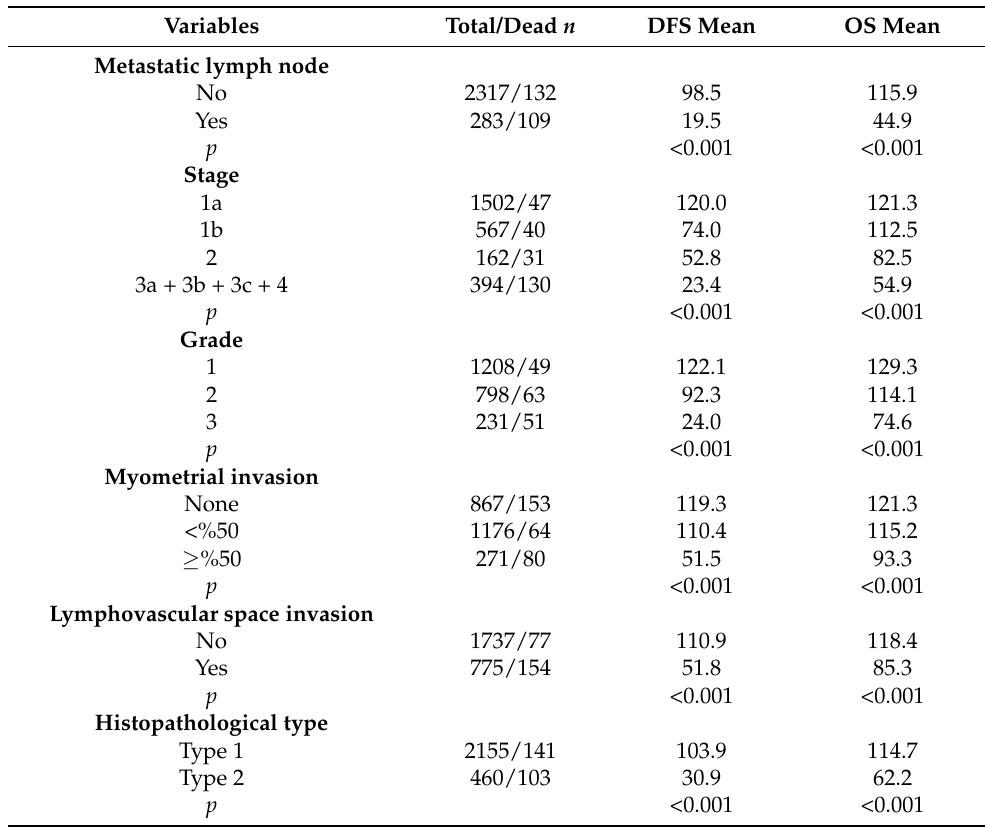
Table 4. Univariate analysis of DFS and OS.